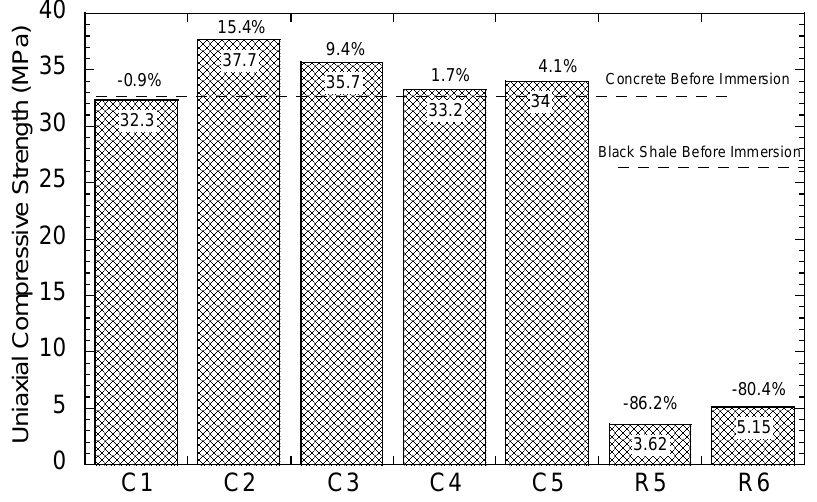
Figure 9. Uniaxial compressive strength of the concrete and rock samples.